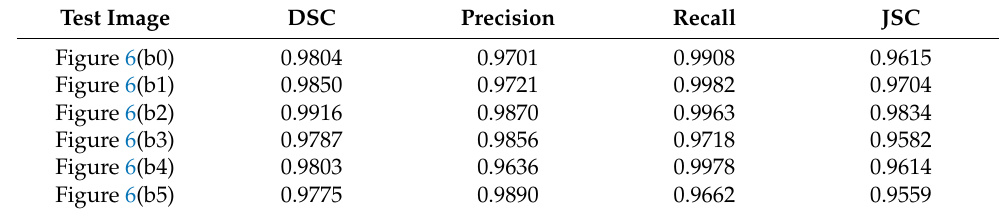
Figure 6. Segmentation results of natural images: ( a 0 –a 5 ) are six different scene segmentation maps without adding noise; ( b 0 –b 5 ) are six different scene segmentation maps with different noise levels. Table 1. Objective